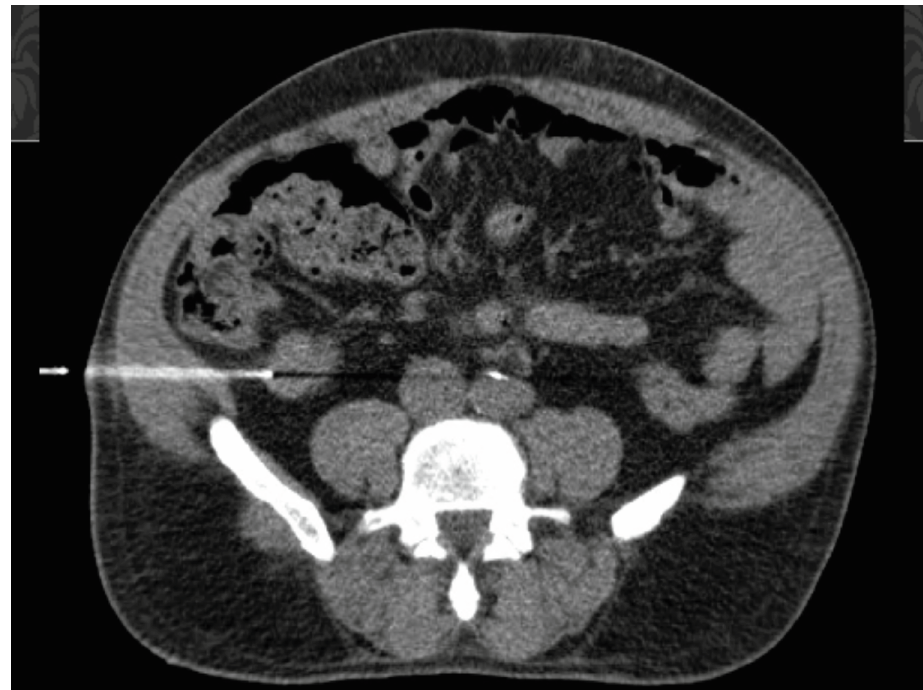
Figure 4: CT-guided core needle biopsy of the appendiceal mass.